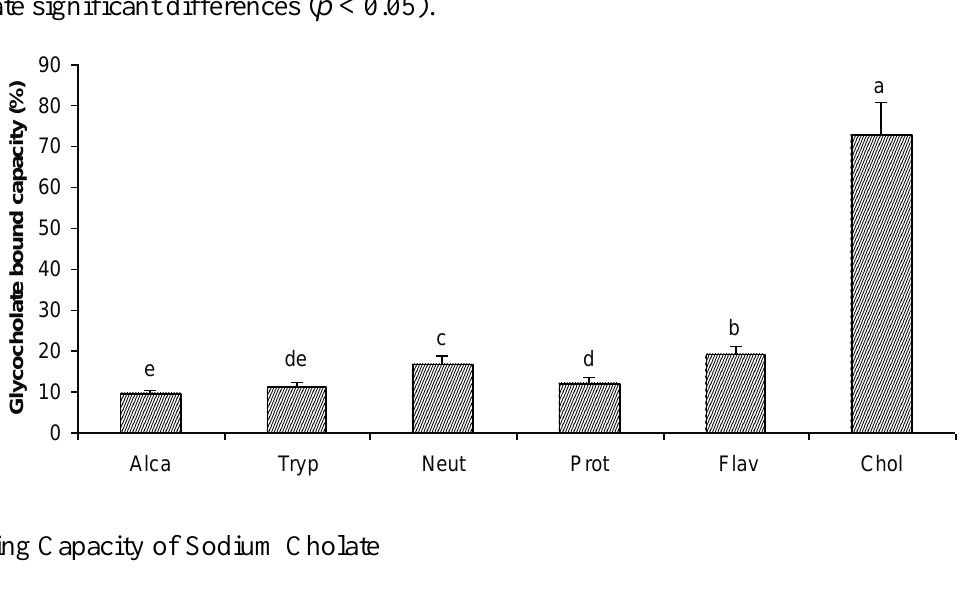
Figure 2. Sodium glycocholate binding by peptides from five differents hydrolysates of defatted corn protein. Alca: Alcalase; Tryp: Trypsin; Neut: Neutrase; Prot: Protamex; Flav: Flavourzyme. Cholestyramine (Chol) was used as a positive control. Different letters indicate significant differences ( p <